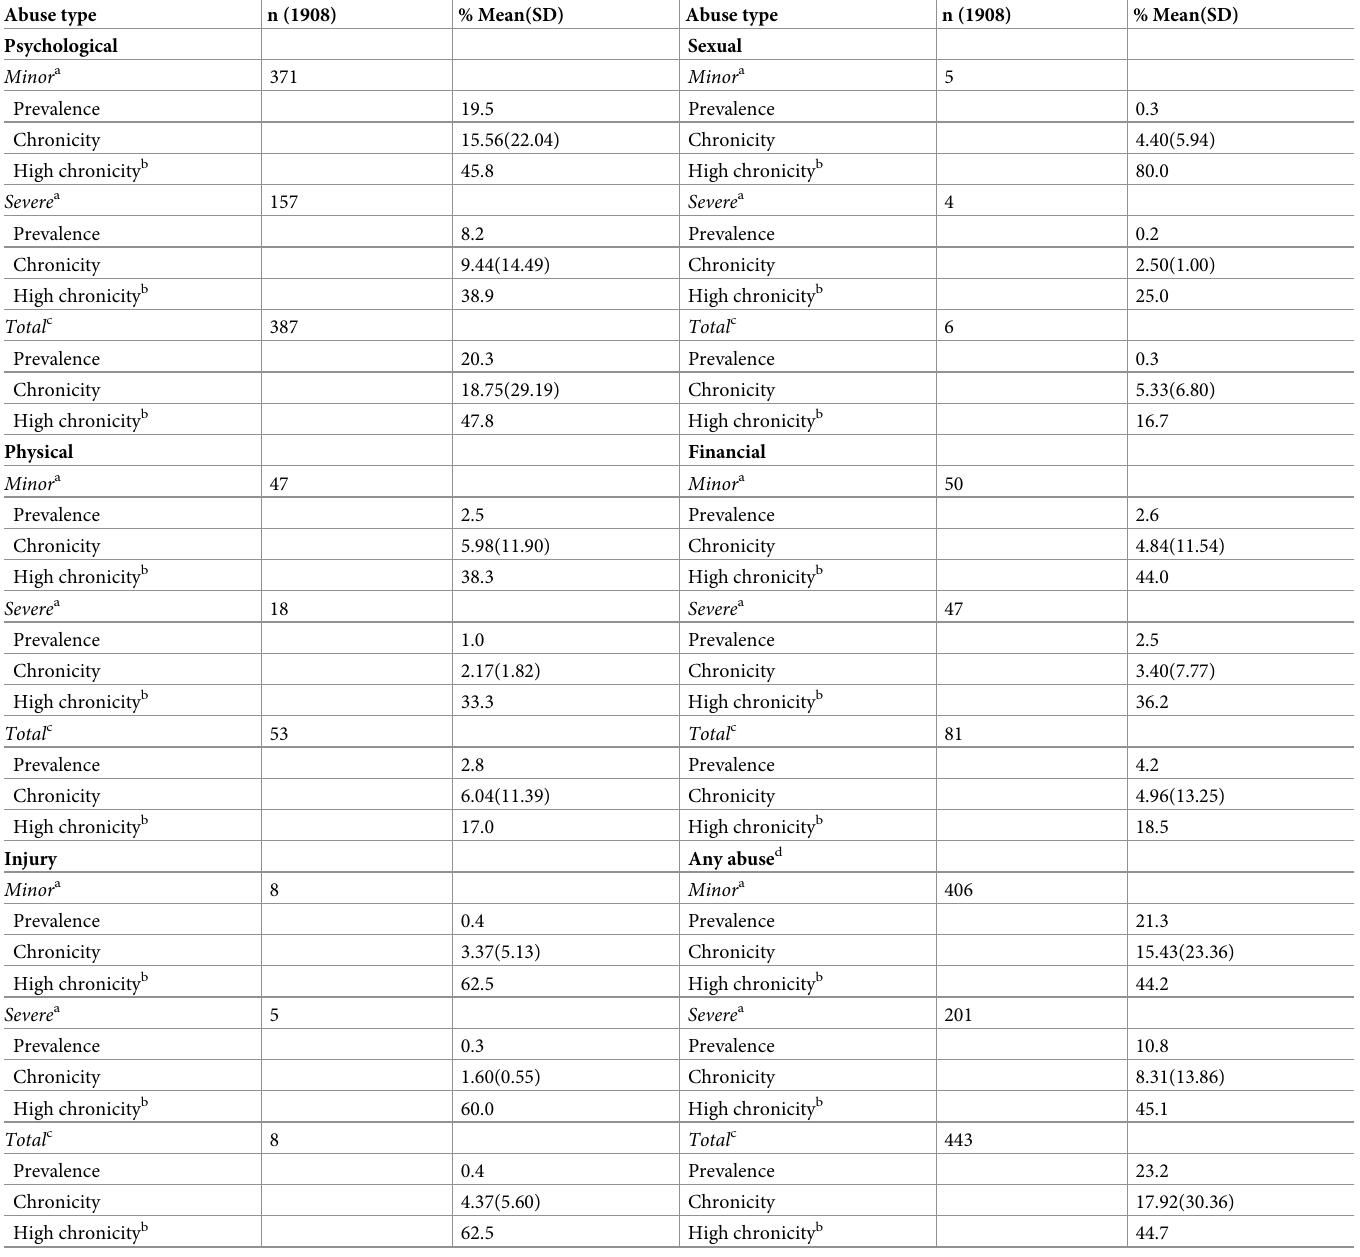
Table 2. Prevalence and chronicity of minor, severe and total abuse experienced by older